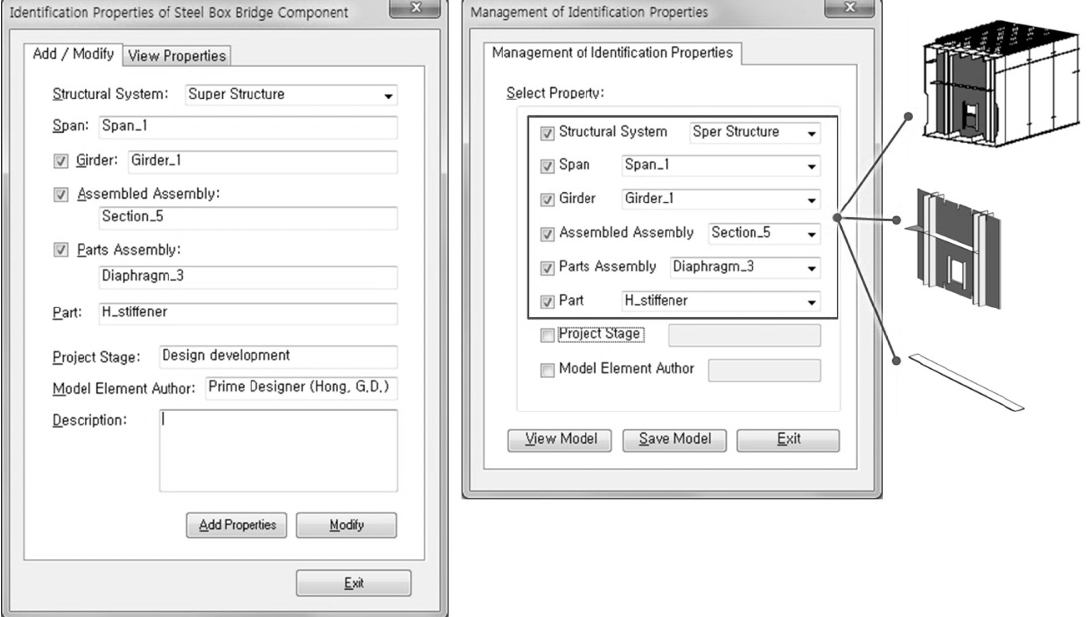
Figure 7. Basic framework for IFC-based bridge information modeling process.